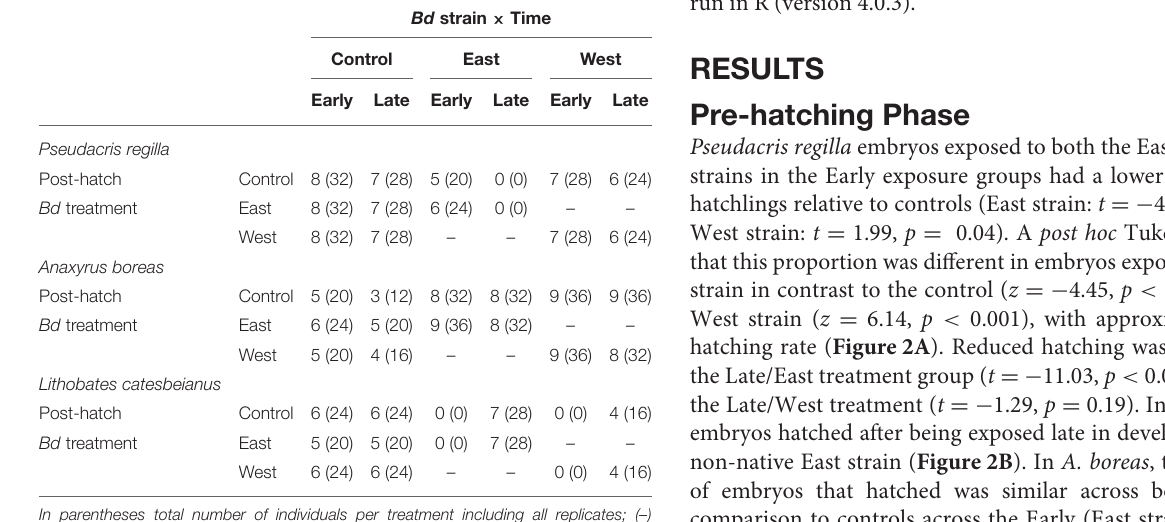
independently by species using odds ratios calculated with a generalized linear mixed model, family: binomial (logit). The values of the ratios represent the likelihood or the risk of mortality due to exposure to the pathogen in comparison to the controls. Therefore, odds ratios higher than 1 represent an increased risk after exposure, odds ratios equal to one TABLE 2 | Number of replicated groups exposed in the different treatments per represent no difference in the risk, and odds ratios lower than species as larvae. 1 represent a lower risk of the exposed group. All analyses were Pre-hatching treatments run in R (version 4.0.3).